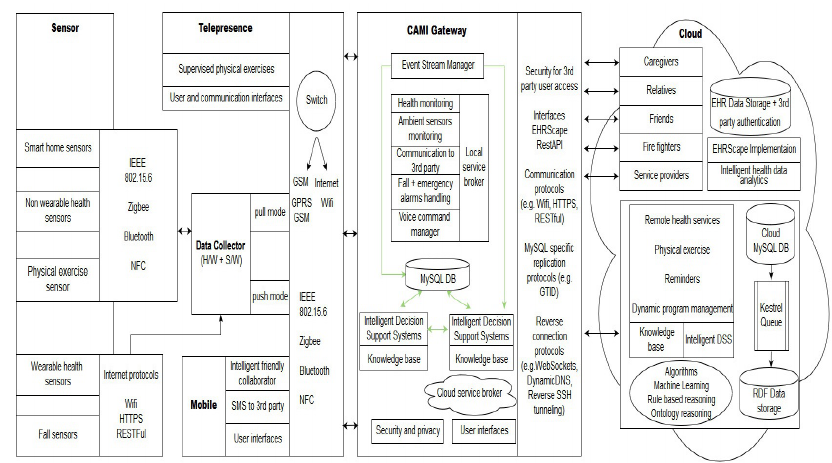
Figure 7. Category 3: A complex configuration: The CAMI AAL System Architecture